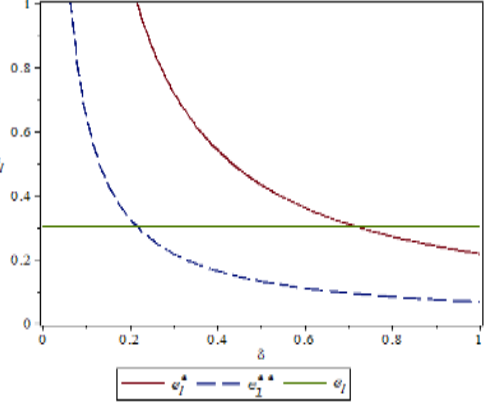
Figure 4. The e ff ect of manufacturer’s behavior δ on the green index of logistics networks. Figure 4. The effect of manufacturer's behavior δ on the green index of logistics networks.